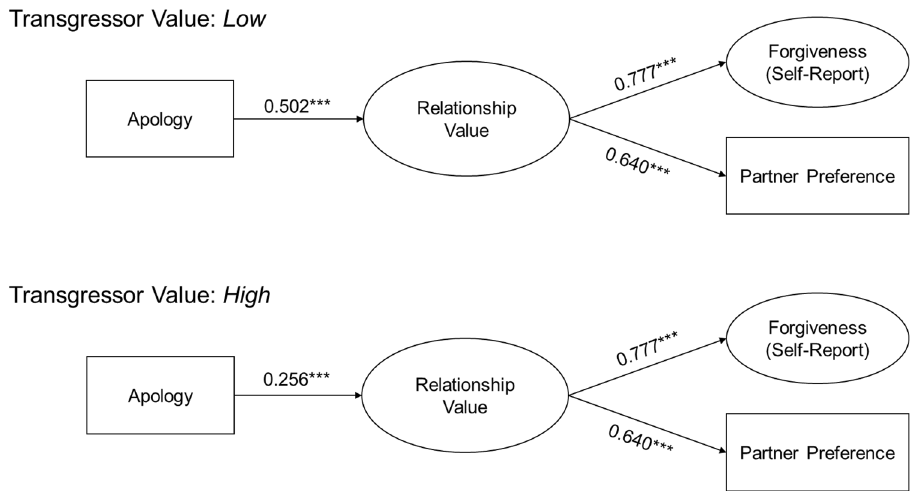
Figure 4. Path model depicting unstandardized simple effects of apologies across levels of transgressor value. A complete list of direct and indirect simple effects is in Table 3. Significant differences in effects across levels of relationship value are conveyed by the interaction terms reported in Fig. 3 and Table 2. *** p <